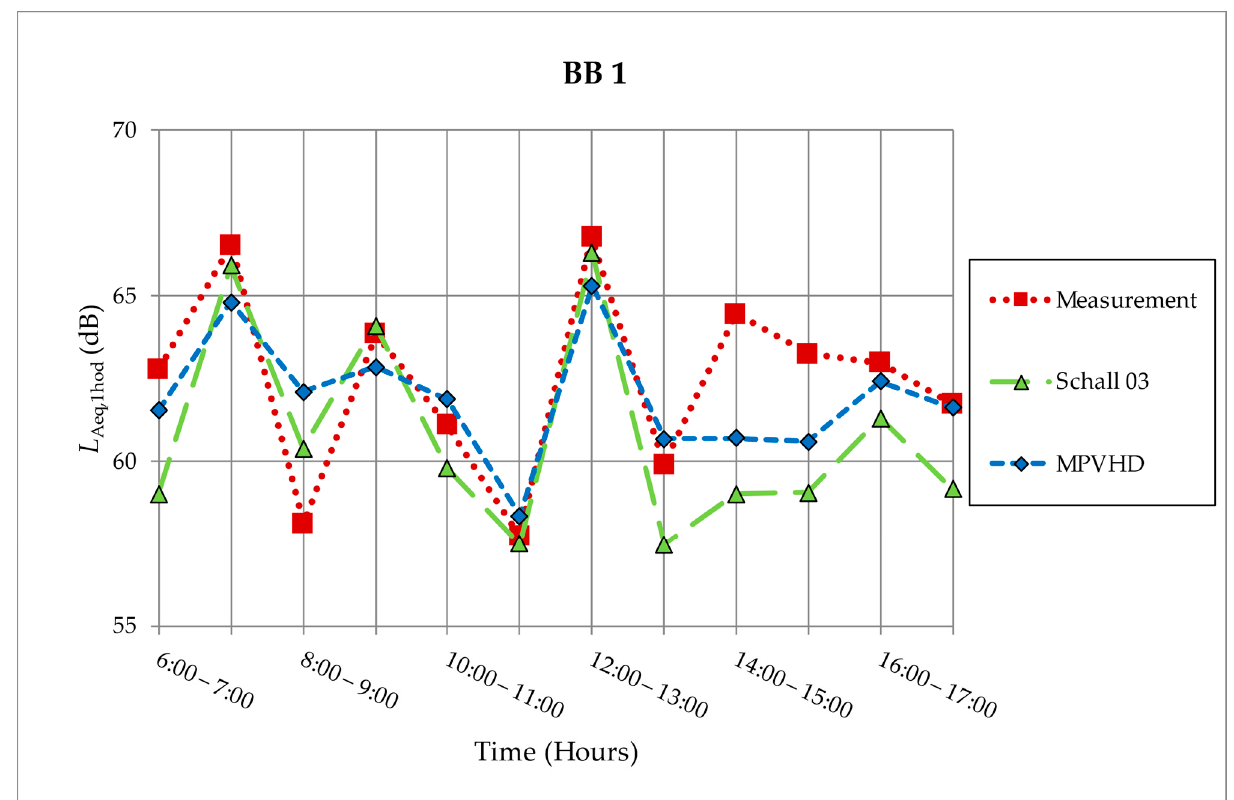
Figure 5. Measurement and prediction of noise from the railway on measurement location BB1 [30].